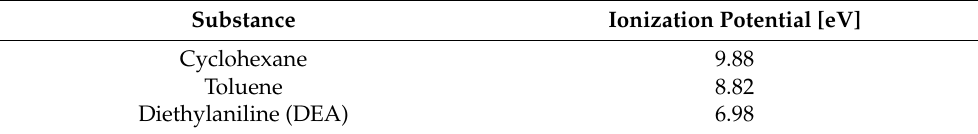
Table 1. The liquids and additives used in the study. For reference the ionization potentials are also listed